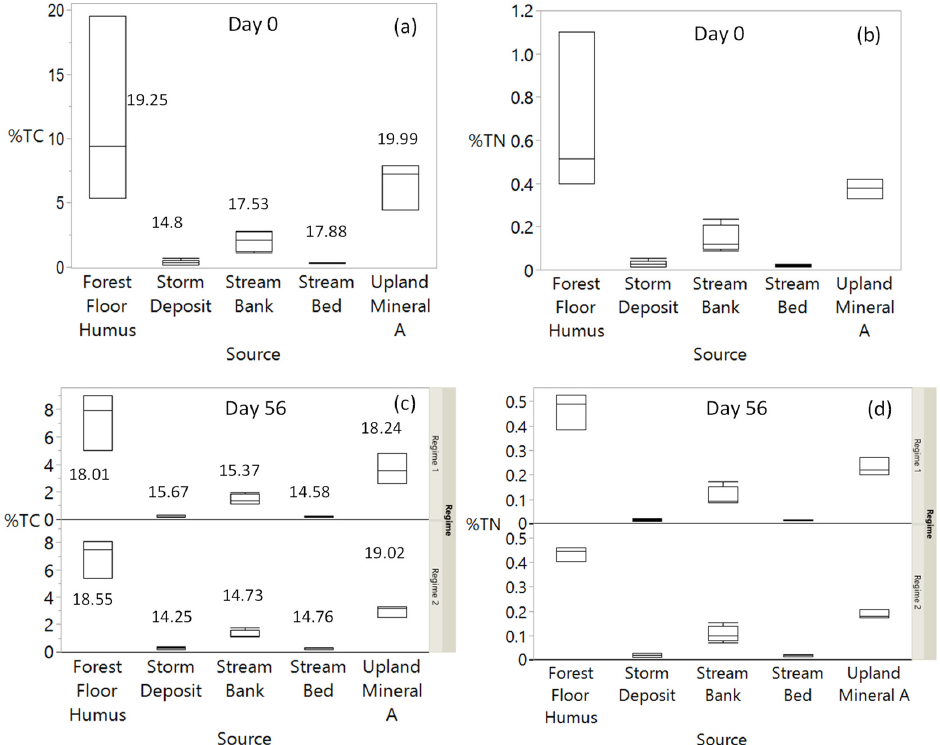
Figure 3. Sediment mean %TC and %TN contents for the five sources and two moisture regimes for day 0 ( a , b ) and day 56 ( c , d ). Regime 1: continuously moist and regime 2: dry–wet cycle are indicated by the top and bottom panels, respectively in ( c , d ). Molar carbon to nitrogen (C:N) for the sources are indicated next to the boxes. The lower bound of the box represents the first quartile (25%), the upper bound represents the third quartile (75%), the horizontal line in the box is the median, whereas the whiskers represent points that fall outside the quartiles but are within 1.5 times the interquartile range.